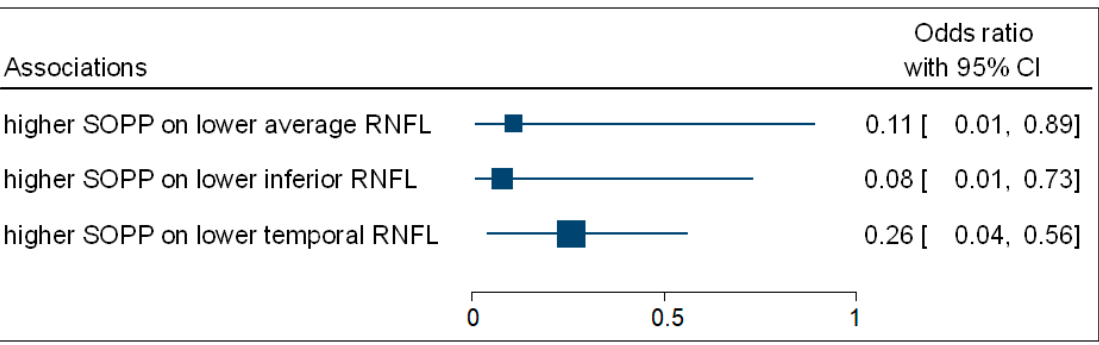
Figure 5. A forest plot showing associations between OPP and ONH-RNFL.